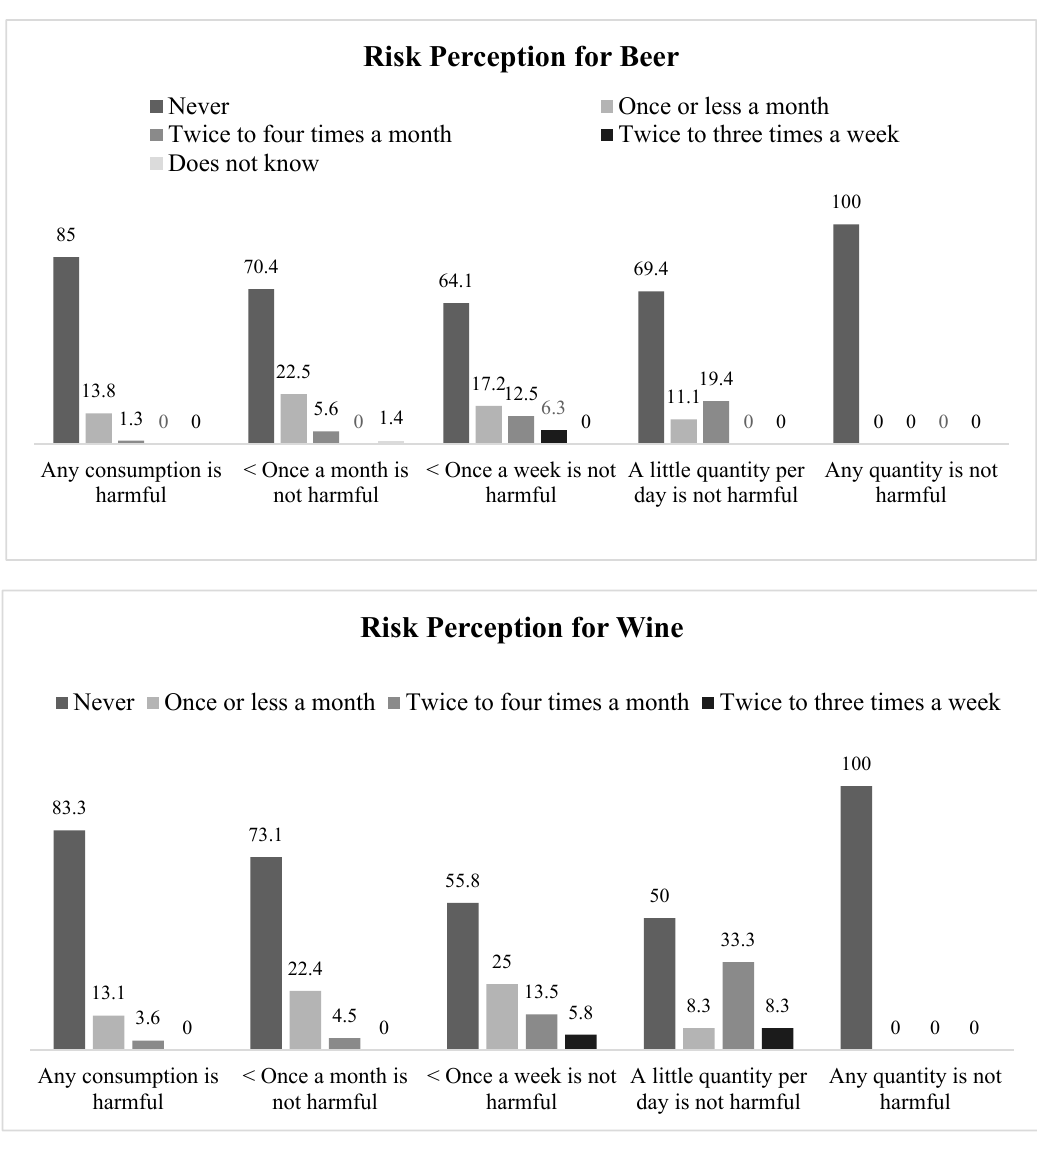
Figure 5. Frequency of alcohol consumption during pregnancy by risk perception of drinking beer and wine.